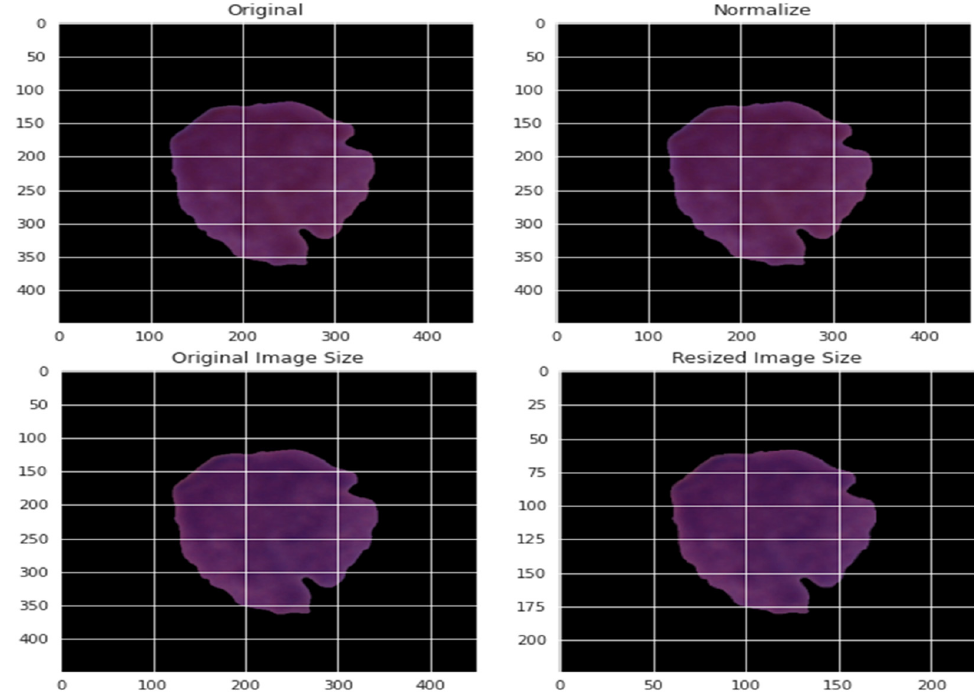
Figure 4. An example of applying the pre-processing stage on blood cells.